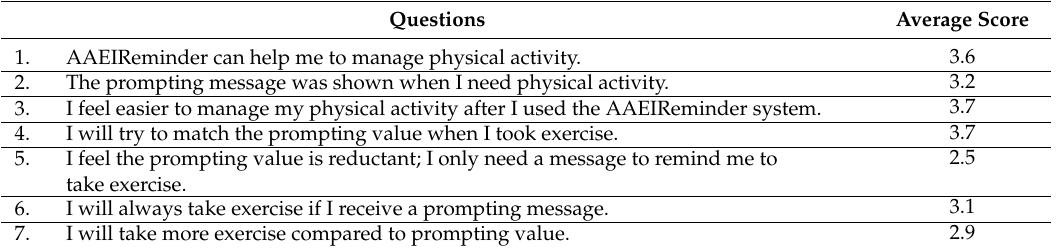
Table 5. User experience analysis.